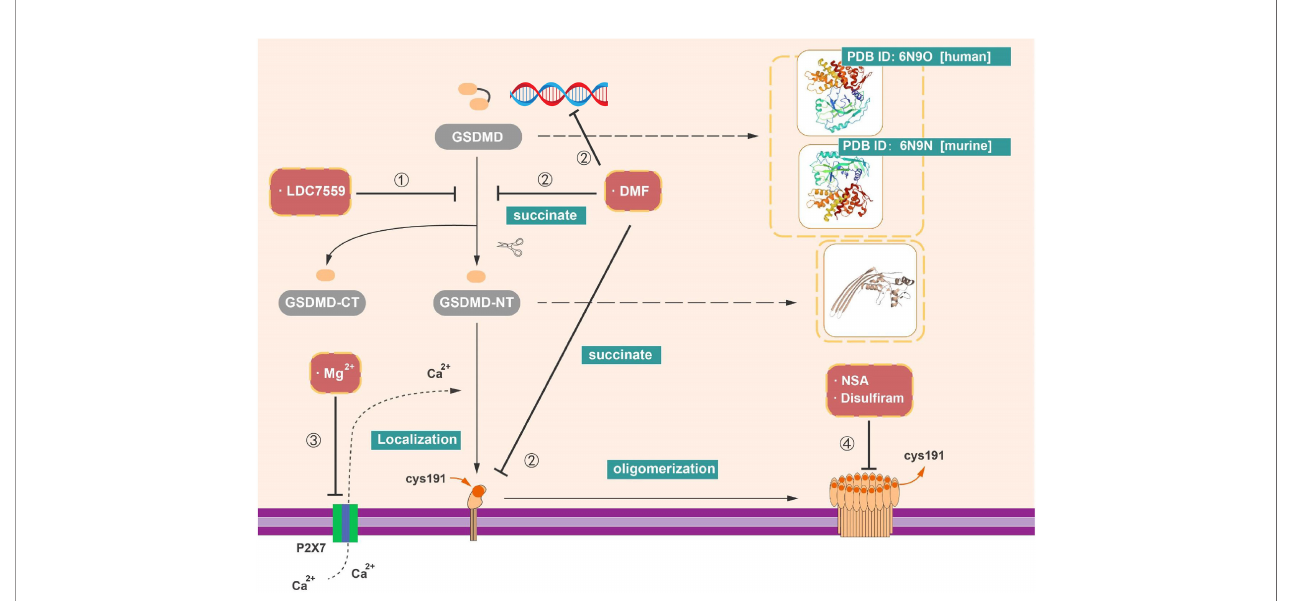
FIGURE 5 | Inhibitors targeting on GSDMD. (1) LDC7559 can inhibit the cleavage of GSDMD as well as reduce the formation of GSDMD-NT. (2) DMF can regulate the transcription of GSDMD. In addition, with the succination of GSDMD, DMF can impede the cleavage and oligomerization of GSDMD. (3) Mg 2+ is able to in fl uence the function of GSDMD-NT, like the insertion of GSDMD-NT into membrane. (4) NSA, disul fi ram, and Mg 2+ have capacity to prohibit pore formation via inhibit the oligomerization of